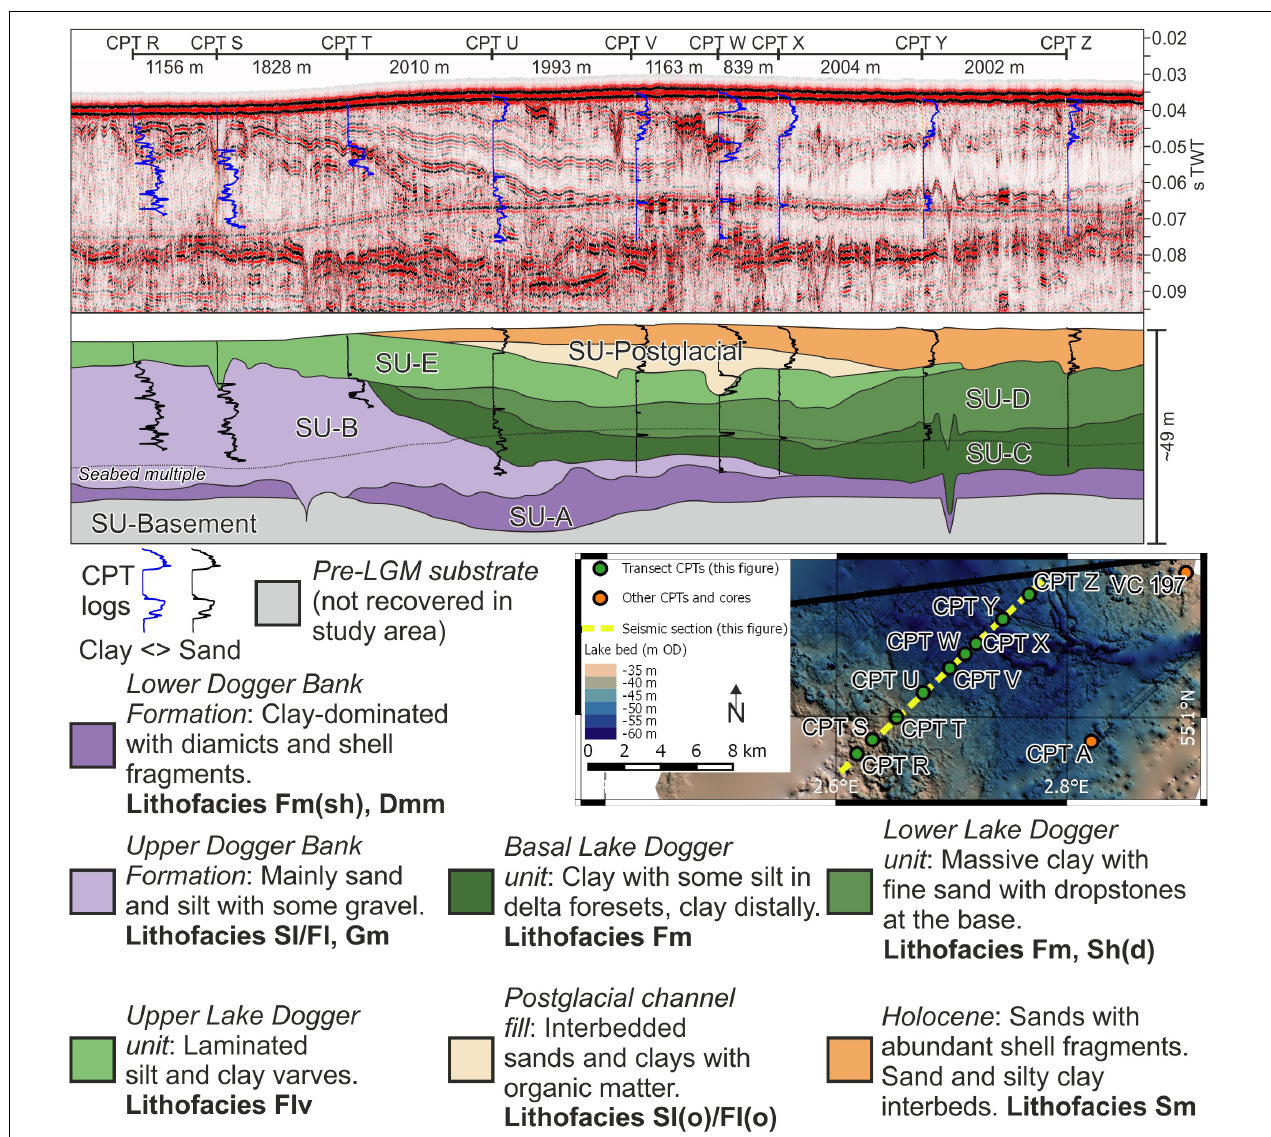
FIGURE 3 | Transect through CPTs showing correlation between lithofacies observed in core and borehole samples, their CPT log characteristics, and seismic facies. Seismic units are described in Table 3 . For descriptions of lithofacies see Table 4